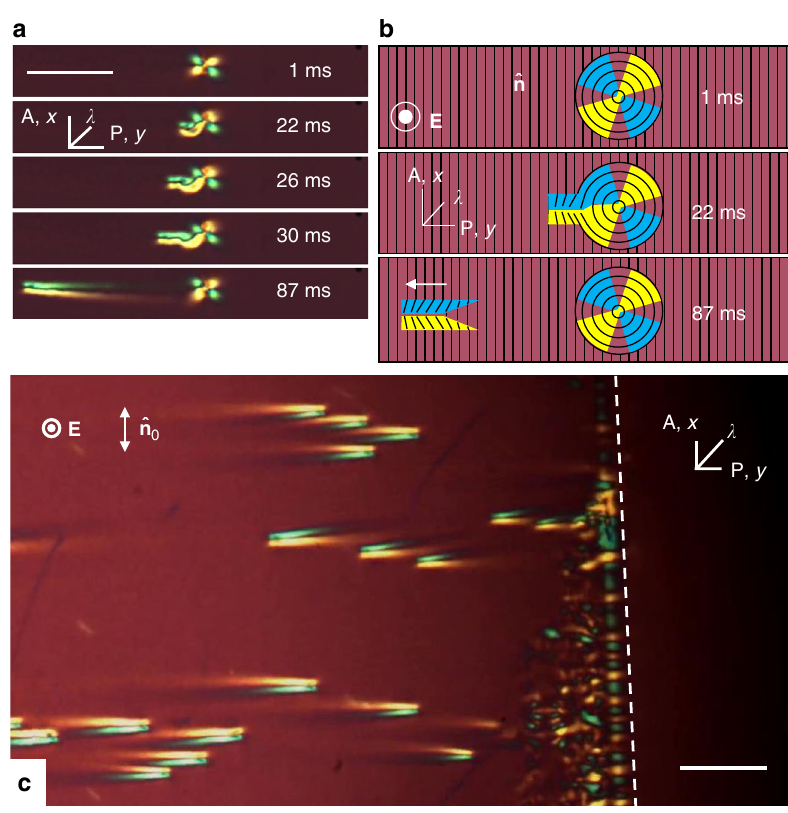
Fig. 5 Nucleation of solitons at irregularities. a Nucleation in a dust particle that creates a circular director fi eld around itself, fi ve instants of time are shown; U = 87.4 V, f = 1000 Hz, T = 45 °C, and d = 8.2 μ m. Scale bar 100 µ m. b Corresponding qualitative in-plane director scheme of nucleation in the dust particle. c Electrode edge (marked by a dashed line) absorbs and nucleates solitons; U = 72.2 V, f = 1000 Hz, T = 50 °C, d = 8.0 μ m. Scale bar 50 µ m